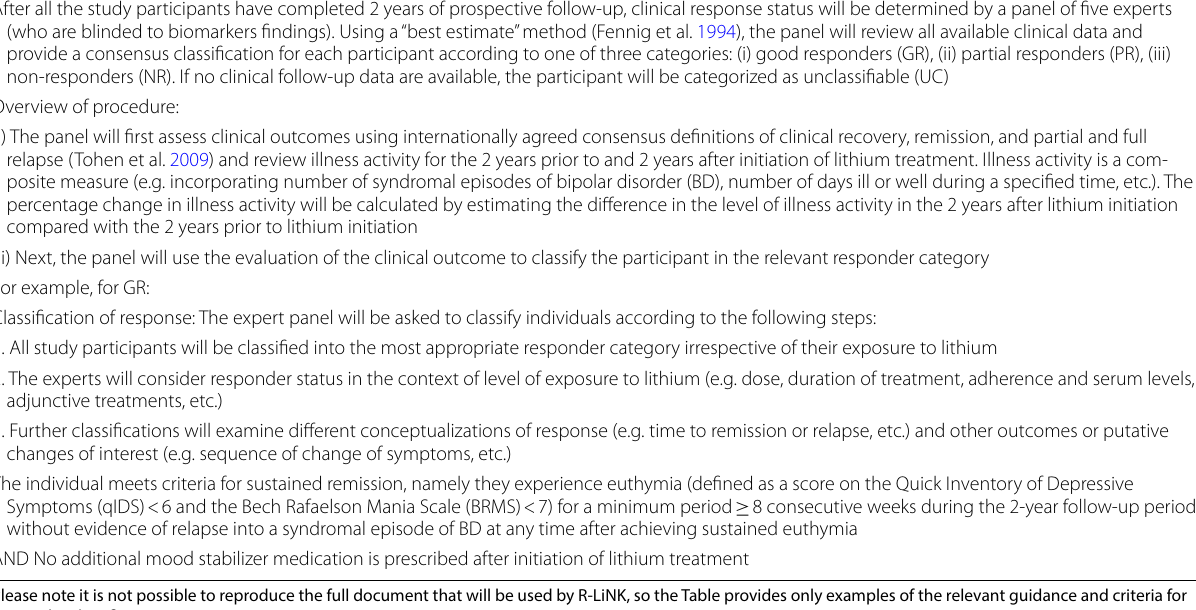
Table 3 Proposed criteria for classifying lithium